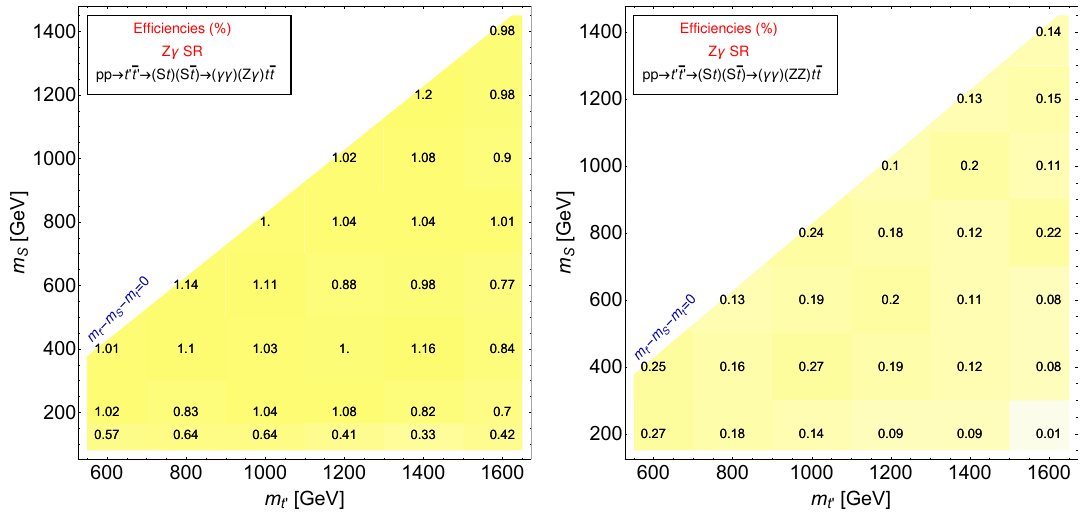
Figure 20 . E(cid:14)ciencies for the Z (cid:13) SR and for channels where at least one of the two S decays into (cid:13) (cid:13) .